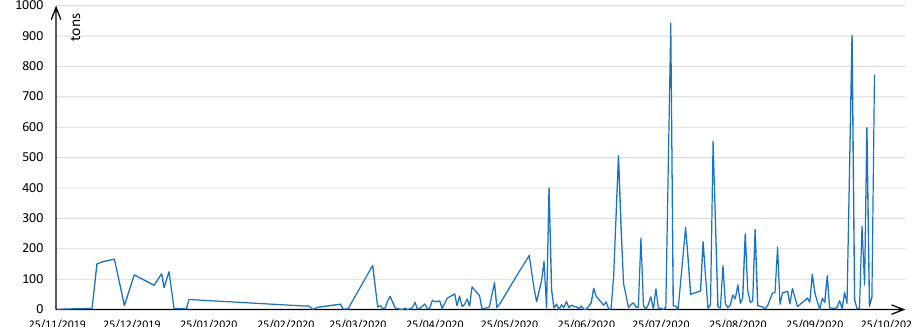
Figure 14. Daily production of steel components traced in the BIM platform.